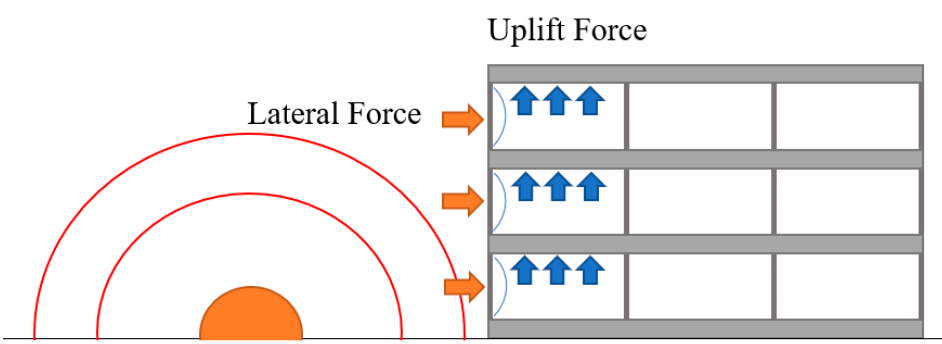
Figure 22. Lateral and uplift pressure caused by a blast incident.